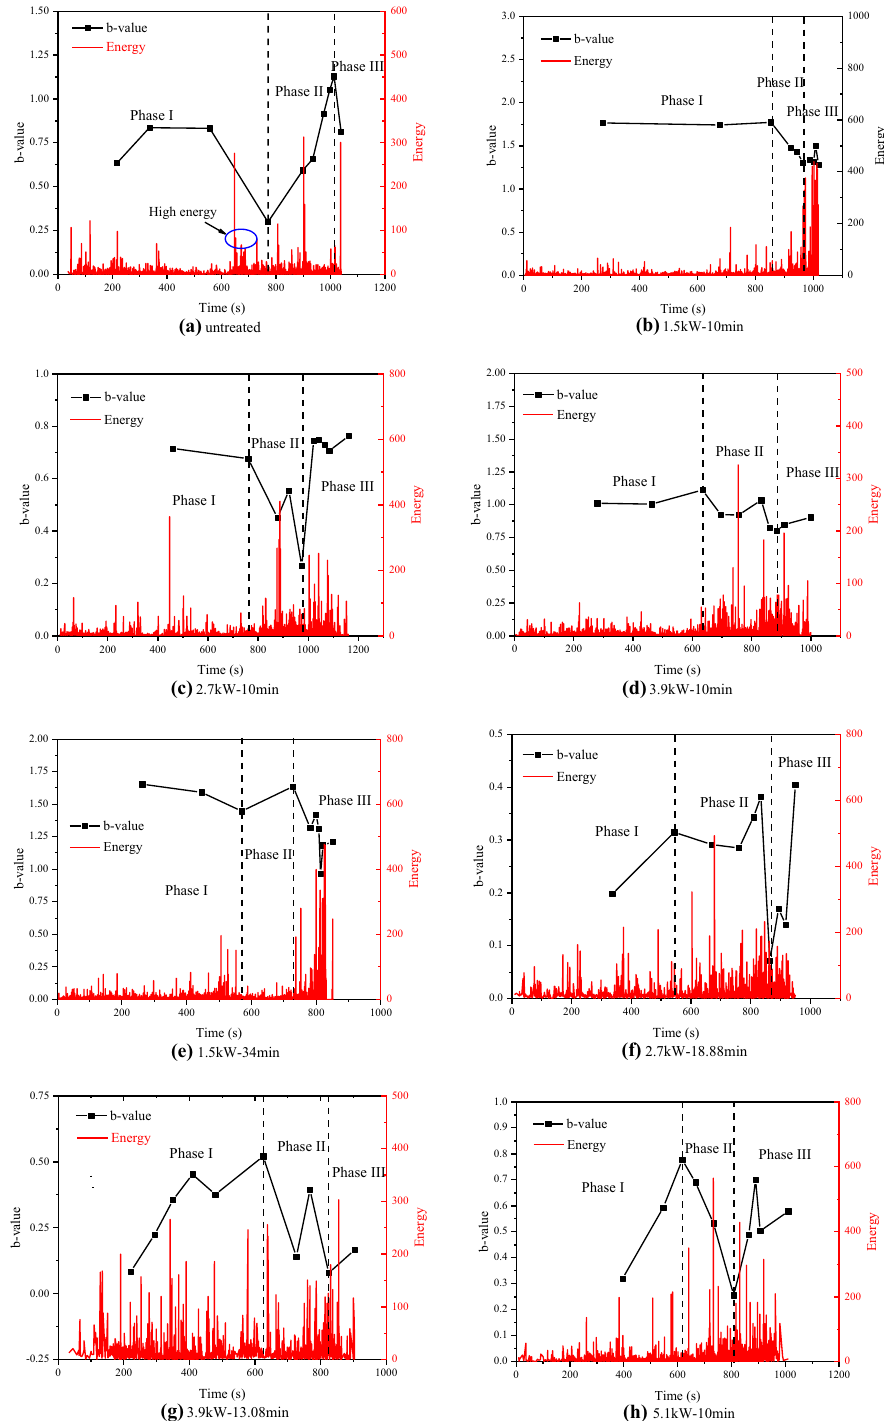
Figure 11. Changes in b-values for various times and various microwave irradiation energies: ( a ) Untreated; ( b ) at 1.5kW for 10 min; ( c ) at 2.7kW for 10 min; ( d ) at 3.9 kW for 10 min; ( e ) at 1.5kW for 34 min; ( f ) at 2.7 kW for 18.88 min; ( g ) at 3.9 kW for 13.08 min; ( h ) at 5.1 kW for 10